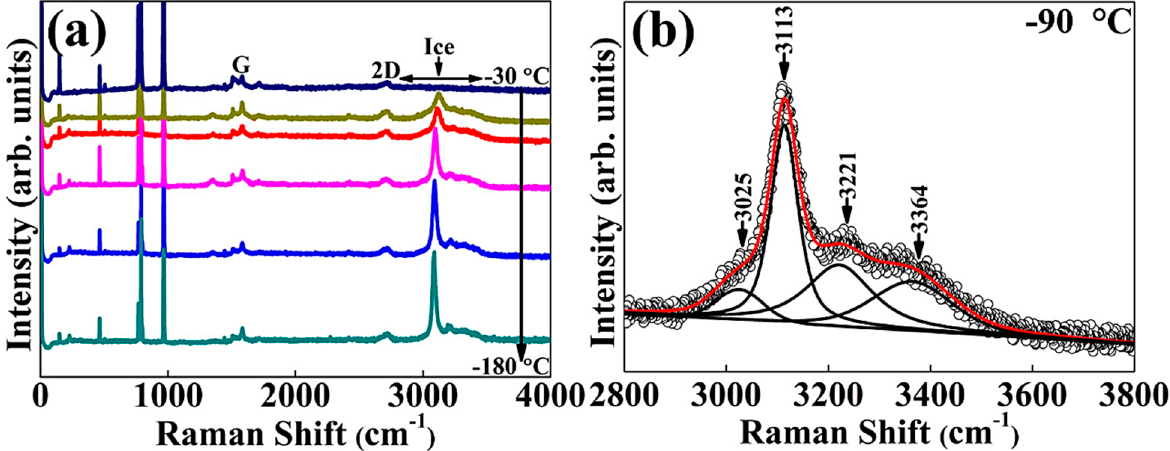
Figure 3. ( a ) Temperature-dependent Raman spectra obtained by focusing the laser to a frozen water droplet ( b ) fitting of the water-related peak obtained at − 90 °C.